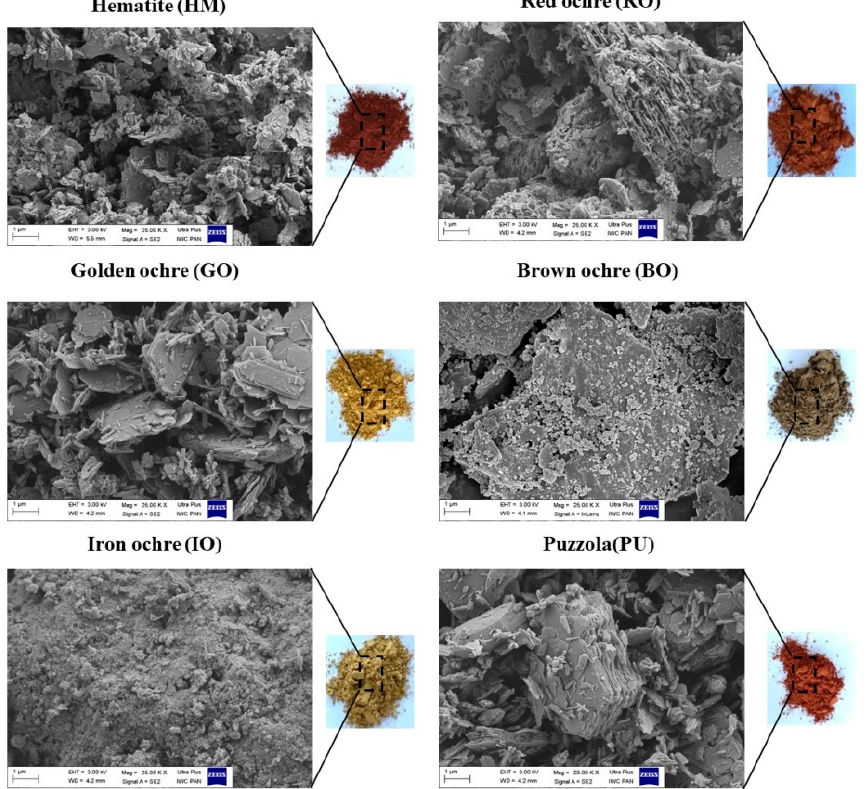
Figure 4. Carbonyl index (CI) parameters of the studied composites at different aging times.